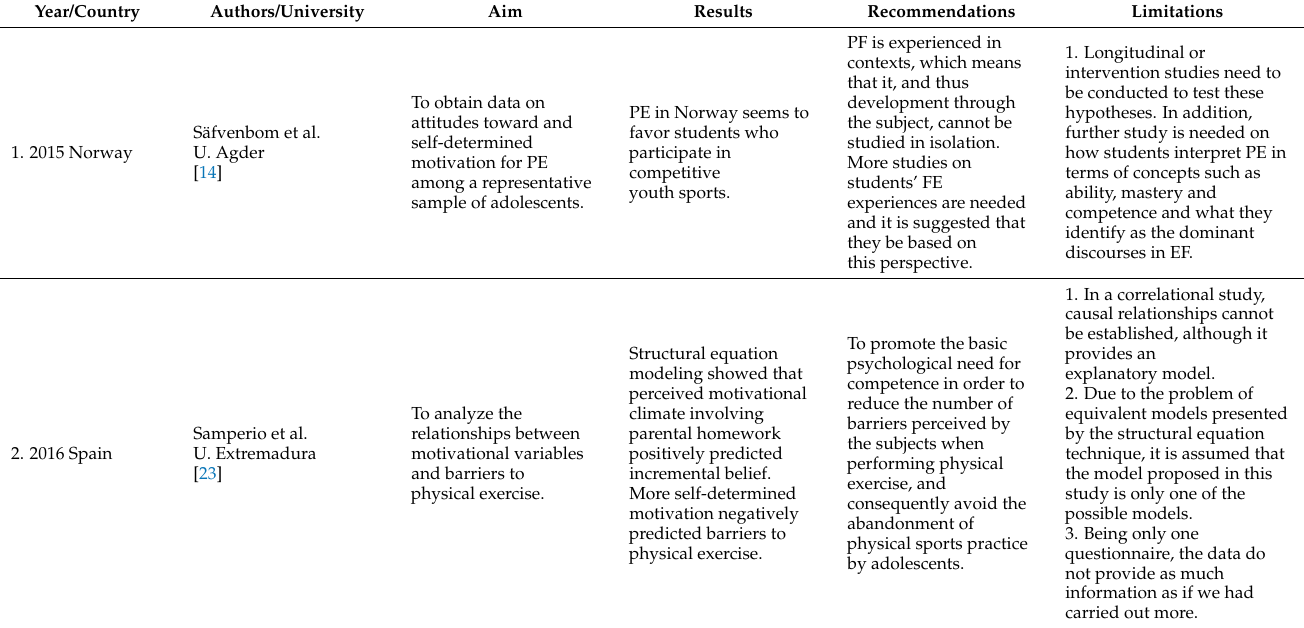
Table 1. Base body of the